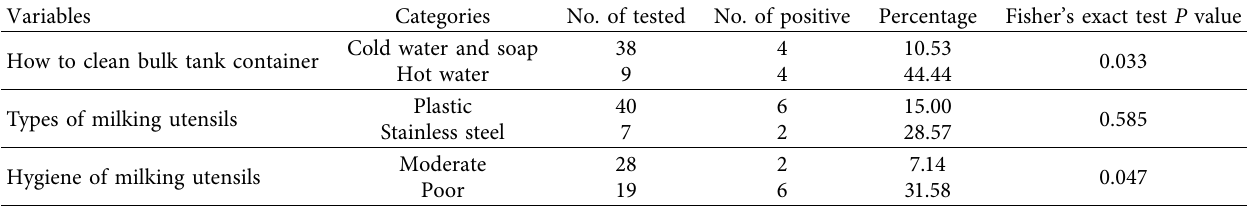
Table 2: Results of the association between the prevalence of Staphylococcus aureus and potential risk factors in bulk tank milk.